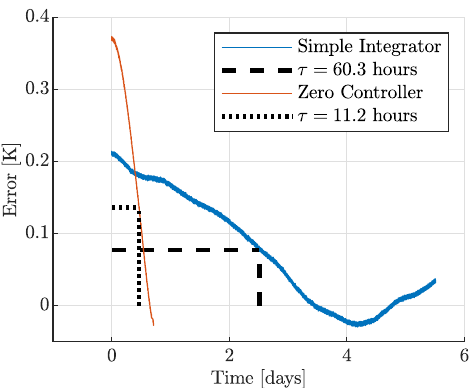
Figure 7. Controller speed after interferometer (ITF) unlock with initial temperature error. The zero controller is five times faster than the simple